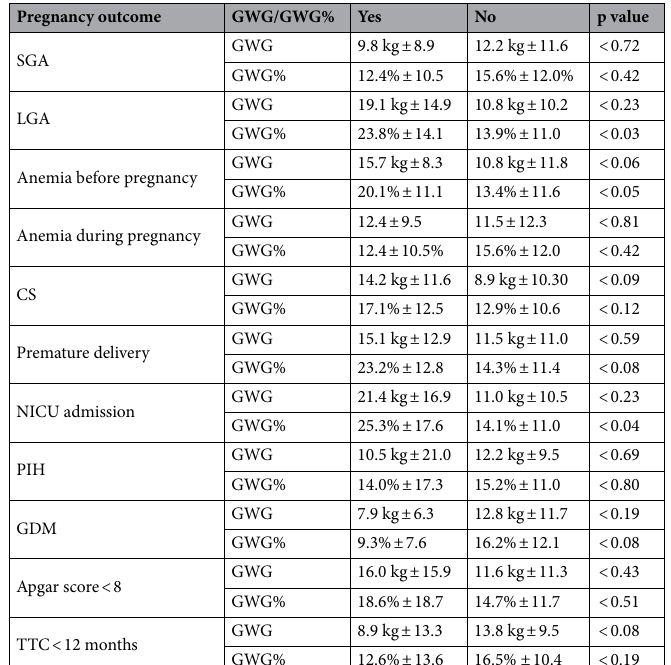
indications, 23.08% due to suspicious of pathological cardiotocography (CTG) tracings and 15.38% due to pro- longed labor. The rate of preterm deliveries was 11.3% (8 patients). 6 newborns needed NICU admission (8.5%). Gestational weight gain. GWG in cases with SGA was 9.8 kg ± 8.9 compared to 12.2 kg ± 11.6 in pregnan- cies ended with a delivery of normal birth weight neonate; p < 0.72. GWG% was 12.4% ± 10.5 in the group of neonates with SGA vs 15.6% ± 12.0% in the normal weight group; p < 0.42. In cases with LGA GWG was 19.1 kg ± 14.9 vs 10.8 kg ± 10.2 in cases with normal birth weight; p < 0.23. The difference was statistically significant in GWG%—23.8% ± 14.1 in the LGA group vs 13.9% ± 11.0 in the normal weight group; p < 0.03. Patients diagnosed with anemia before pregnancy had GWG 15.7 kg ± 8.3 and patients without pre-preg- nancy anemia had GWG 10.8 kg ± 11.8; p < 0.06. The results presented as GWG% were of statistical significance (20.1% ± 11.1 vs 13.4% ± 11.6); p < 0.05. Neither GWG (12.4 vs 11.5 kg), nor GWG% (15.5 vs 14.8%) differed between patients diagnosed with anemia in pregnancy and those without. GWG (14.2 kg ± 11.6 vs 8.9 kg ± 10.30; p < 0.09) and GWG% (17.1% ± 12.5 vs 12.9% ± 10.6; p < 0.12) seemed higher in the group of pregnancies ended with CS, but these results were not of statistical significance. GWG in pregnancies that ended with premature delivery was15.1 kg ± 12.9 vs 11.5 kg ± 11.0 in pregnan- cies ended at term; p < 0.59. GWG% was in pregnancies that ended with premature delivery 23.2% ± 12.8 vs 14.3% ± 11.4 in pregnancies ended at term; p < 0.08. GWG was 21.4 kg ± 16.9 in patients whose infants were admitted to neonatal intensive care unit (NICU) compared to 11.0 kg ± 10.5 in cases without NICU admission; p < 0.23. The difference was statistically signifi- cant when presented as GWG%, with GWG% 25.3% ± 17.6 in patients whose infants were admitted to neonatal intensive care unit (NICU) vs 14.1% ± 11.0 in cases without NICU admission; p < 0.04. GWG was 10.5 kg (± 21.0) vs 12.2 kg (± 9.5); p < 0.69 in patients who developed PIH; respectively GWG % was 14.0% (± 17.3) vs 15.2% (± 11.0); p < 0.80. In case of GDM GWG was 7.9 kg (± 6.3) vs 12.8 kg (± 11.7); p < 0.19; respectively GWG % was 9.3% (± 7.6) vs 16.2 (± 12.1); p < 0.08. Mothers of newborns with Apgar score lower than 8 points had mean GWG of 16.0 kg (± 15.9) vs 11.6 kg (± 11.3); p < 0.43; their GWG% was 18.6% (± 18.7) vs 14.7% (± 11.7); p < 0.51. The mean GWG was 8.9 kg (± 13.3) in patients who had TTC lower than 12 months compared to 13.8 kg (± 9.5) in those with TTC of 12 months and more; p < 0.08; respectively, GWG% was 12.6% (± 13.6) vs 16.5% (± 10.4); p < 0.19. The relations between GWG, GWG% and pregnancy outcomes are presented in Table 2. We did not find statistical significance between SGA, LGA, pregnancy anemia, pre-pregnancy anemia, cesar- ean section, preterm delivery or NICU admission of the newborn and time-to-conception interval. The relations